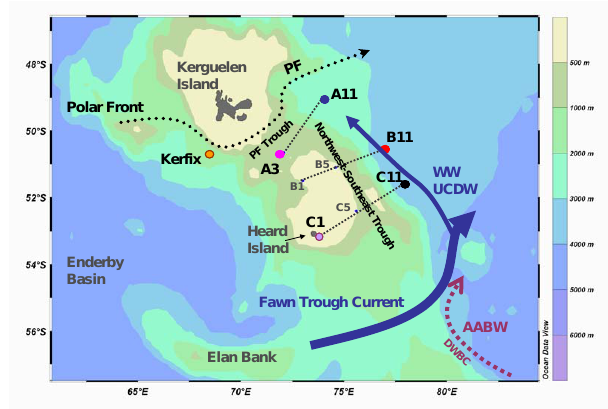
Fig. 1. Sample location and major hydrographical features during KEOPS (inspired from Park et al., 2008). The 6 stations (out of 9) analysed for Pa (dissolved and particulate) are highlighted on the map. Blue arrow: Fawn Trough Current (38 Sv = 38 × 10 6 m 3 s − 1 ) and its northward branch along the eastern escarpment of the Kerguelen plateau, carrying Winter Water (WW) and Circumpo- lar Deep Water (Upper and Lower CDW). Dotted purple arrow: Antarctic Bottom Waters (AABW) coming via the Deep Western Boundary Current from the Adelie Land. This figure was realised using Ocean Data View (R. Schlitzer, http://odv.awi.de,